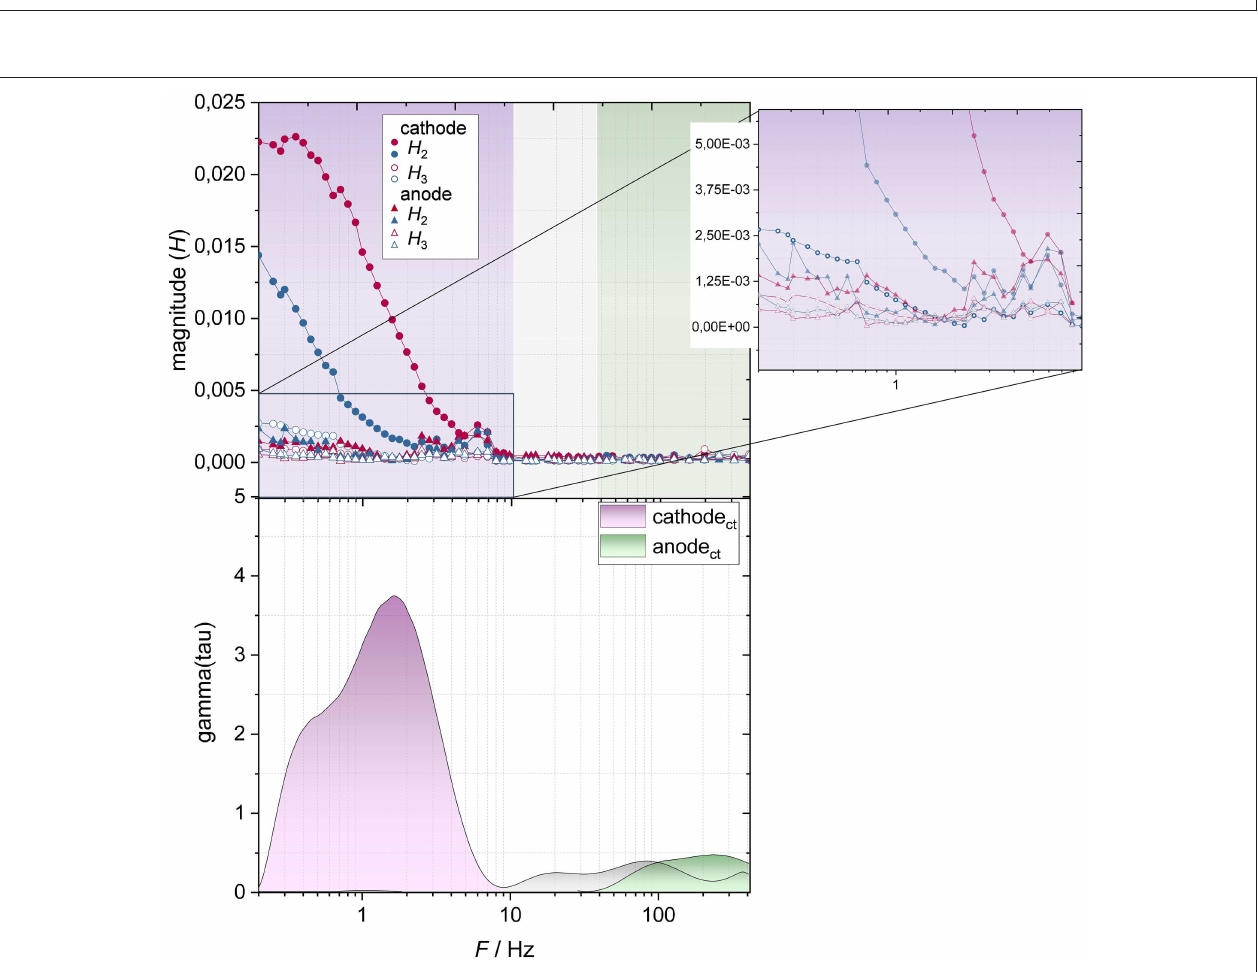
FIGURE 8 | Electrode-resolved NLEIS spectra (Top) for charge (red) and discharge (blue) direction and electrode-resolved DRT plot (Bottom) of the lithium-ion battery at a cell voltage of 3.3V at a temperature of 20 ◦ C.